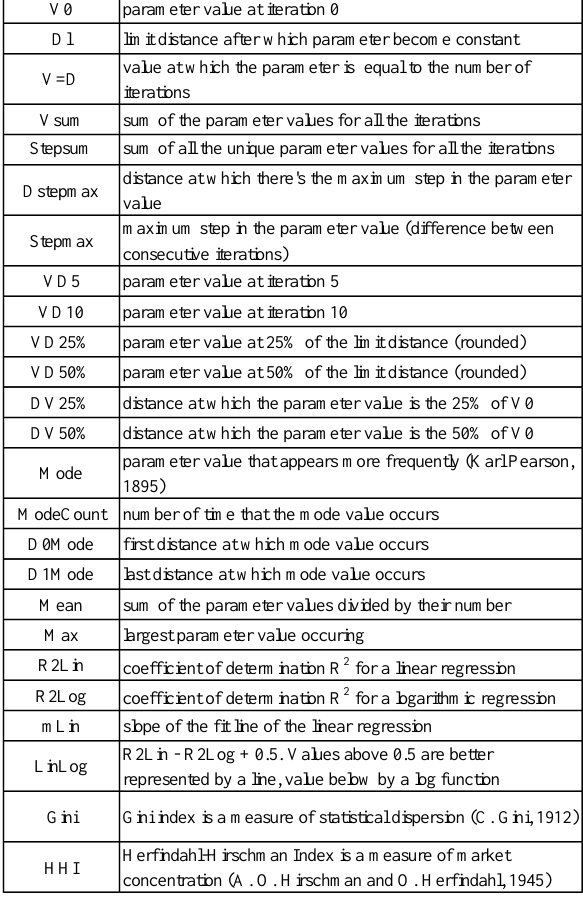
Table 2 . List with the acronym and the description of the statistics